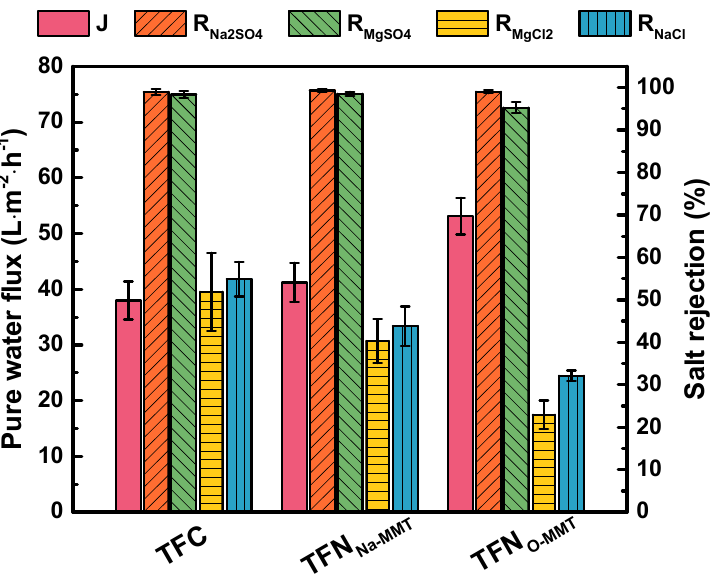
Figure 10. Nanofiltration performance of composite membranes. Feed = 1000 ppm salt solution; Operating condition: pH = 7, 6 bar, 30 °C. Particle concentration = 0.05 g O-MMT/ g TMC.